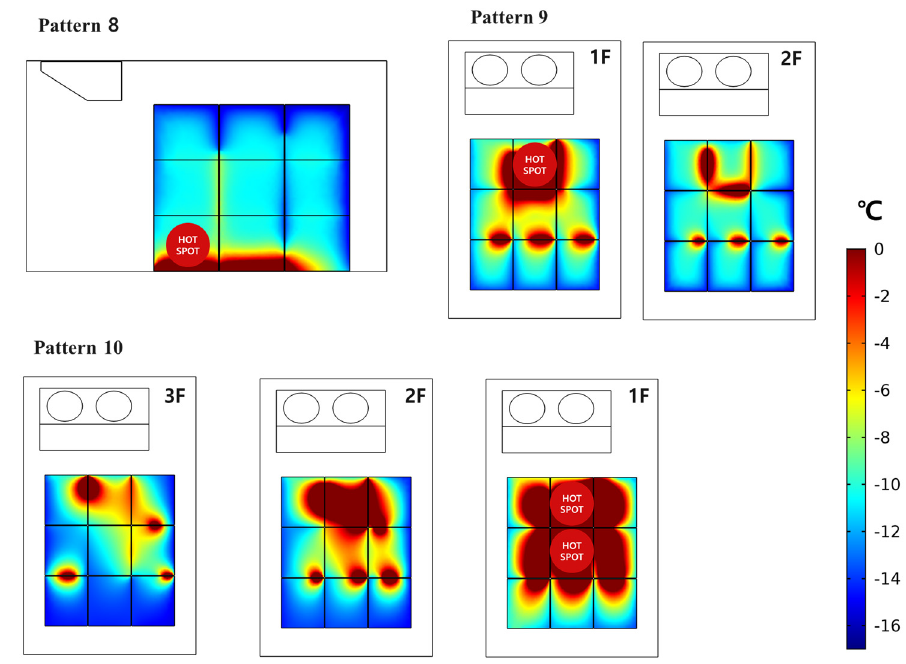
Figure 13. Predicted location of the box with the highest temperature depending on loading patterns (8) to (10).